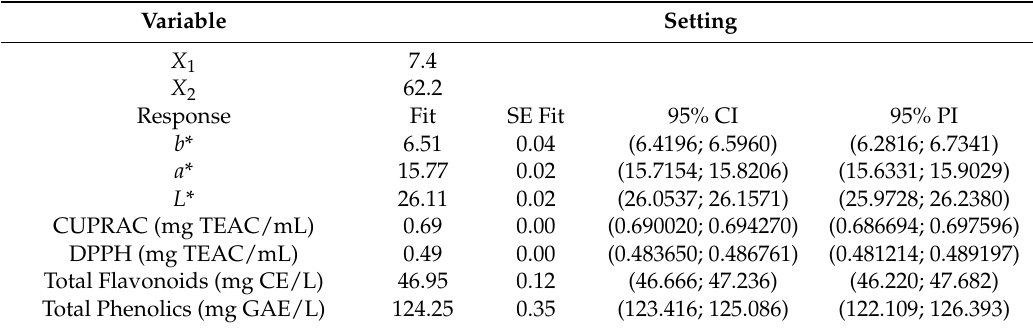
Table 6. Maximum optimization values, according to the response surface